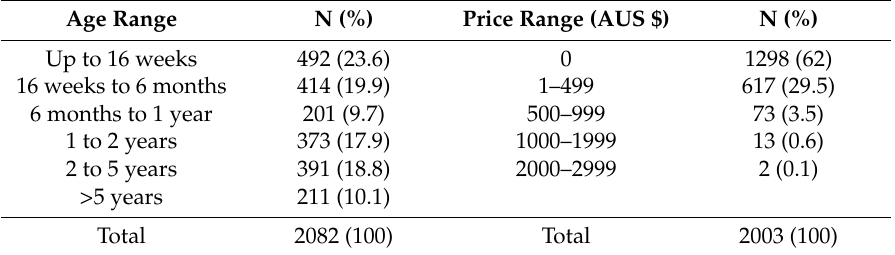
Table 5. Price and age ranges of kittens and cats sold on Gumtree from 9 to 26 February 2016. There were 11 ads in which no age was provided and 90 ads in which no price was